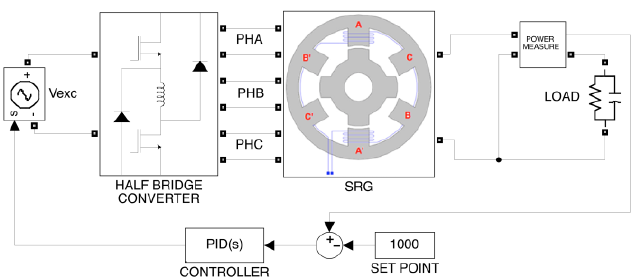
Fig. 4. Scheme for Matlab/Simulink